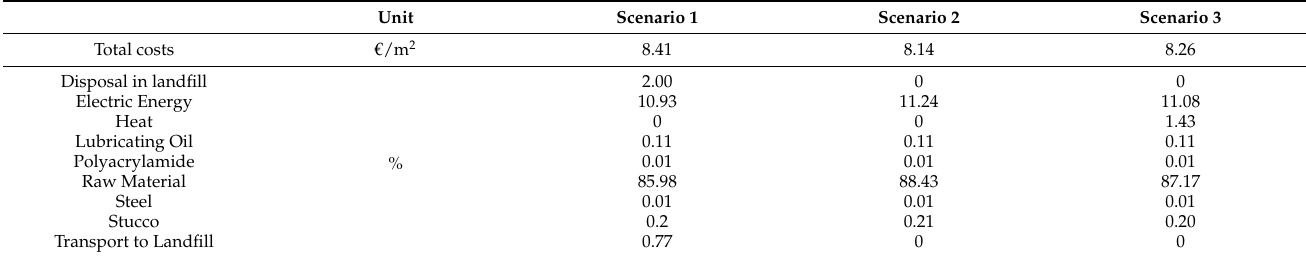
Table 8. Life-Cycle Costs and process cost contribution in Scenarios 1–3.